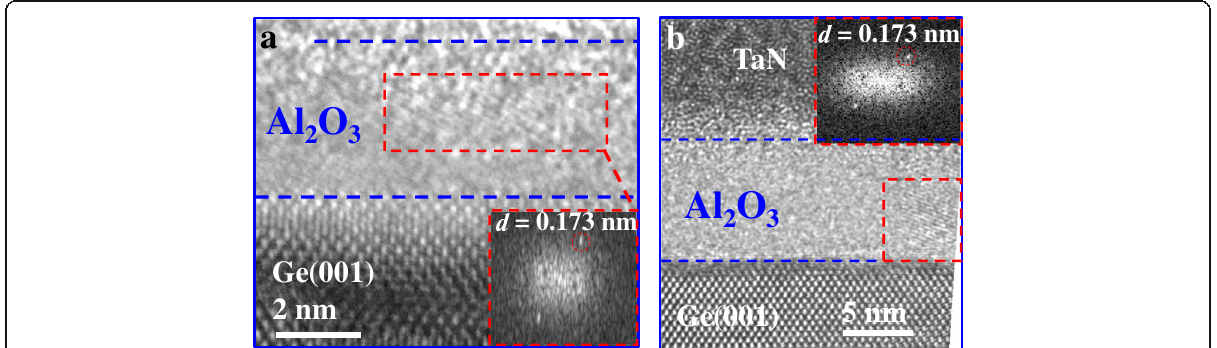
Fig. 3 HRTEM images showing nanocrystals embedded in amorphous Al 2 O 3 for the samples with thicknesses of a 3.6 nm and b 6 nm. Insets show that the interplanar spacing d in the nanocrystal is 0.173 nm, corresponding to o-ZrO 2 (111) phase